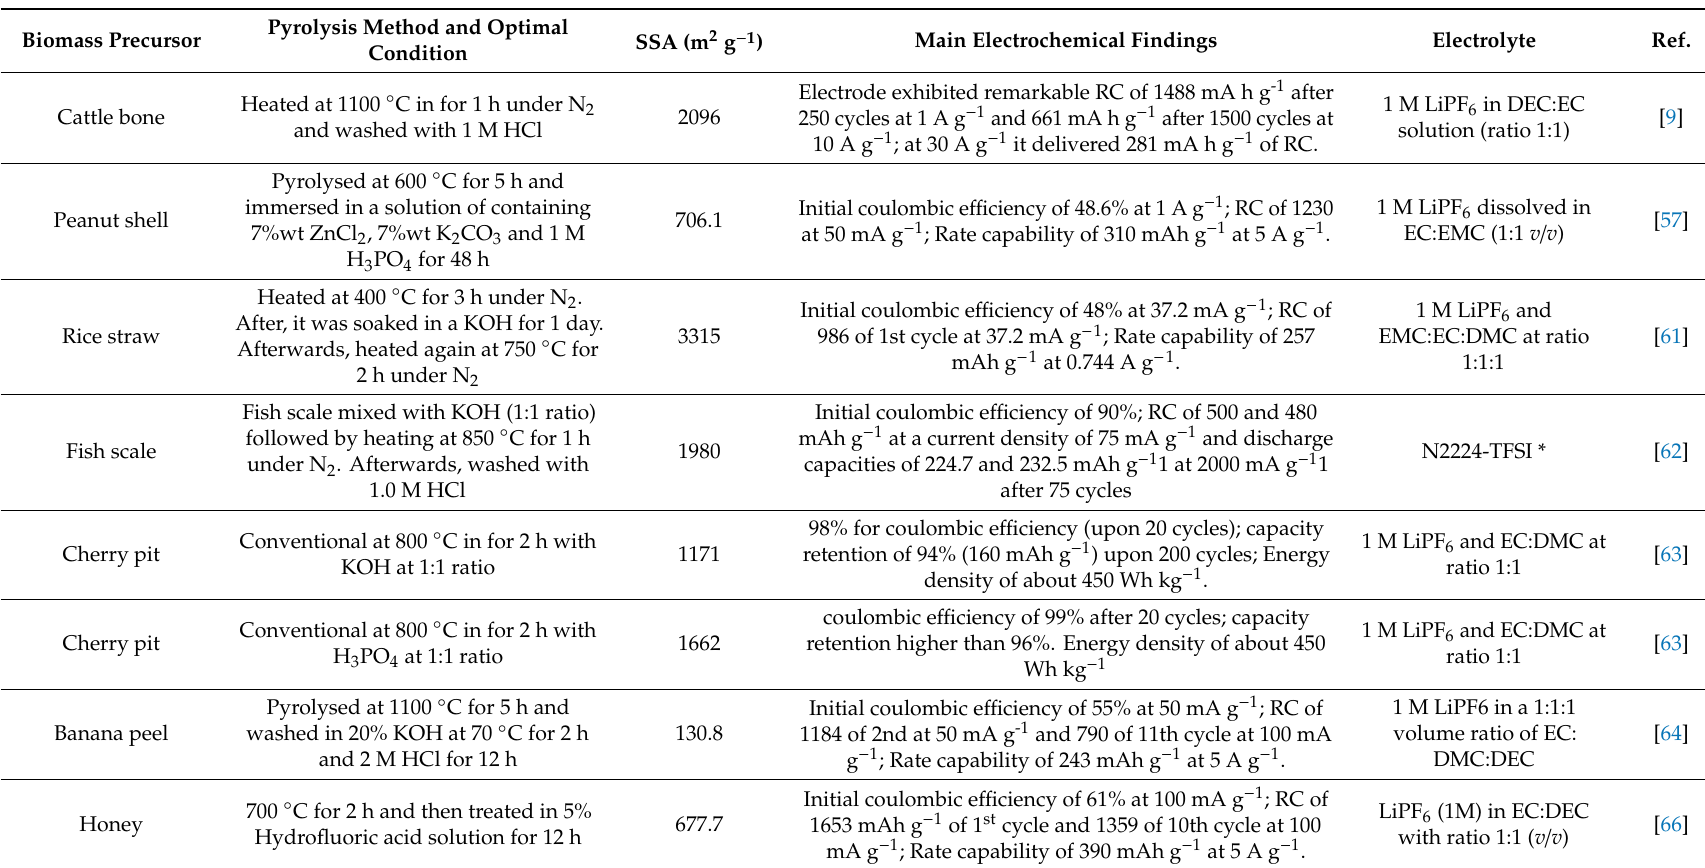
Table 2. Electrochemical performance of some representative biomass residues derived CEs for Li-ion